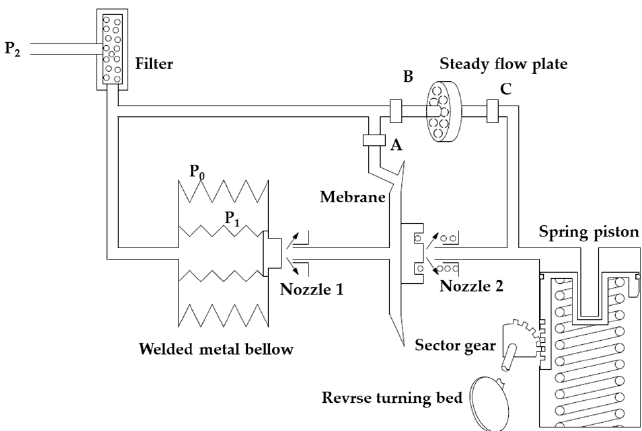
Figure 1. Schematic diagram of two-stage partial pressure relief valve.